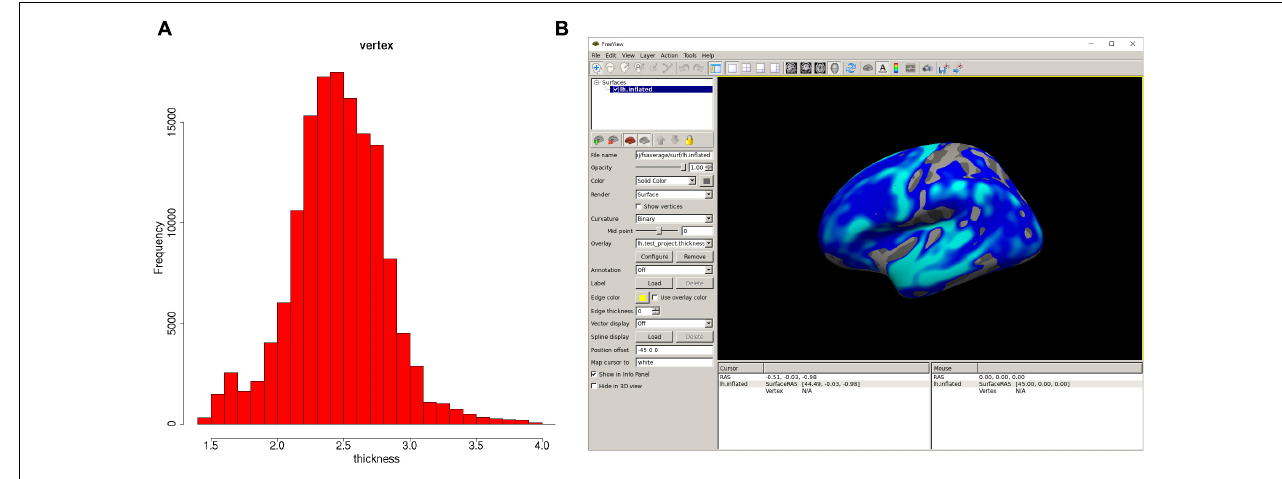
FIGURE 3 | Plots of the QDECR analysis results. (A) A histogram of the vertex-wise mean cortical thickness for the study sample, generated with “hist.” (B) FreeView can be called with the “freeview” function. This panel displays the vertex-wise map for the effect of age on cortical